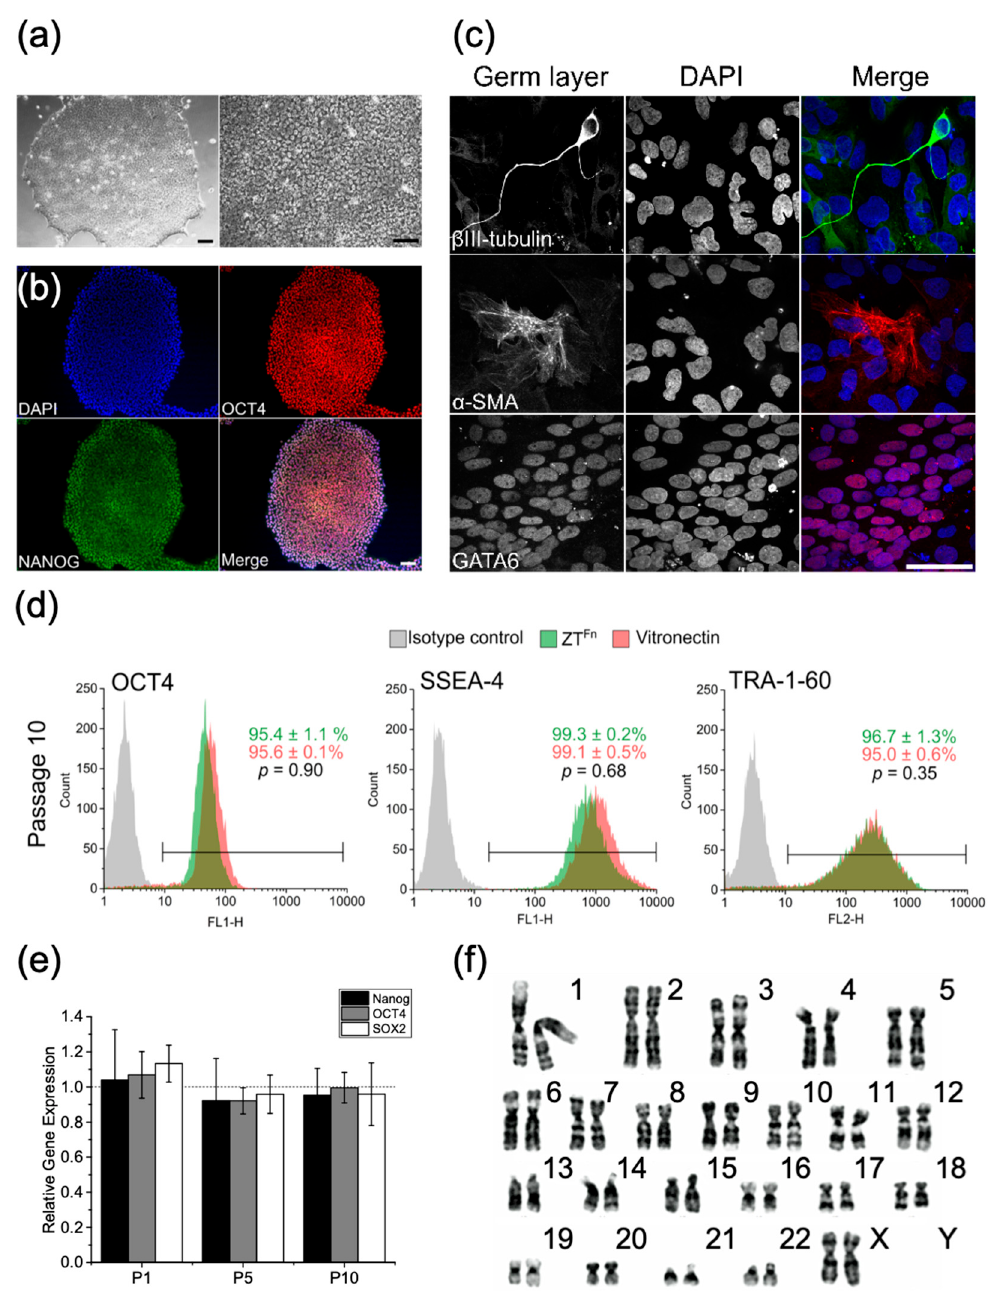
Figure 6. Culturing of human induced pluripotent stem cells (hiPSCs) on the ZT Fn polymer. ( a ) Representative phase contrast micrographs of hiPSCs cultured on ZT Fn for 10 passages. Scale bar = 100 µ m. ( b ) Representative epifluorescence micrographs of hiPSCs cultured on ZT Fn for 10 passages. Cells were stained for nuclei (blue), OCT4 (red), and NANOG (green). A merged channel image is shown. Scale bar = 100 µ m. ( c ) Confocal micrographs show embryoid body-derived cells stained for markers of the three primary germ layers; β -III tubulin (ectoderm), α -SMA (mesoderm), and GATA-6 (endoderm). Cells were counterstained with DAPI (blue). Scale bar = 50 µ m. ( d ) Flow cytometry histograms for pluripotency markers OCT4, SSEA-4, and TRA-1-60 derived from hiPSCs cultured on ZT Fn or vitronectin for 10 passages. The average percentage of positive cells ± SEM is shown ( n = 3). ( e ) Quantitative RT-qPCR analysis of NANOG , OCT4, and SOX2 expression levels in hiPSCs cultured on ZT Fn for 1, 5, and 10 passages relative to cells cultured on vitronectin. Error bars represent SEM ( n = 3). ( f ) Representative karyogram of hiPSCs cultured on ZT Fn for 10 passages ( n =